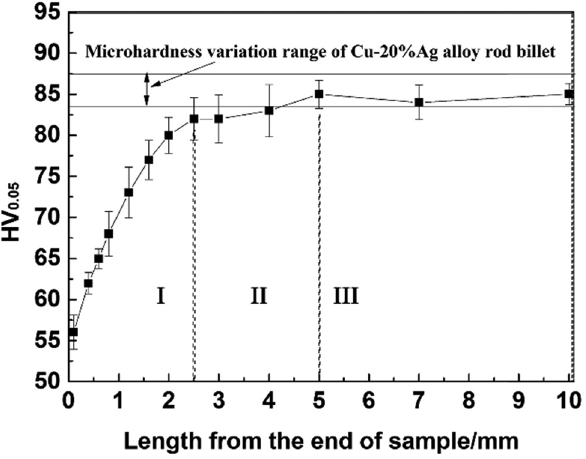
Figure 2: Microhardness variation curve of Cu – 20% Ag alloy end within 10